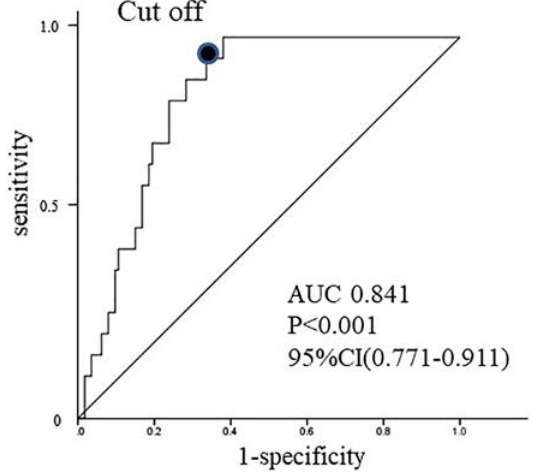
Figure 3 Receiver operating characteristic (ROC) curve for distinguishing the completed group from the conversion group. The area under the curve is 0.841 (95% confidence interval, 0.771–0.911) and the cutoff value for the peri-appendiceal fat density that results in the highest sensitivity and specificity ( ● ) is –40.51 Hounsfield units. Completed group: adult patients in whom the intended procedure was completed; conversion group: adult patients who underwent conversion from the intended